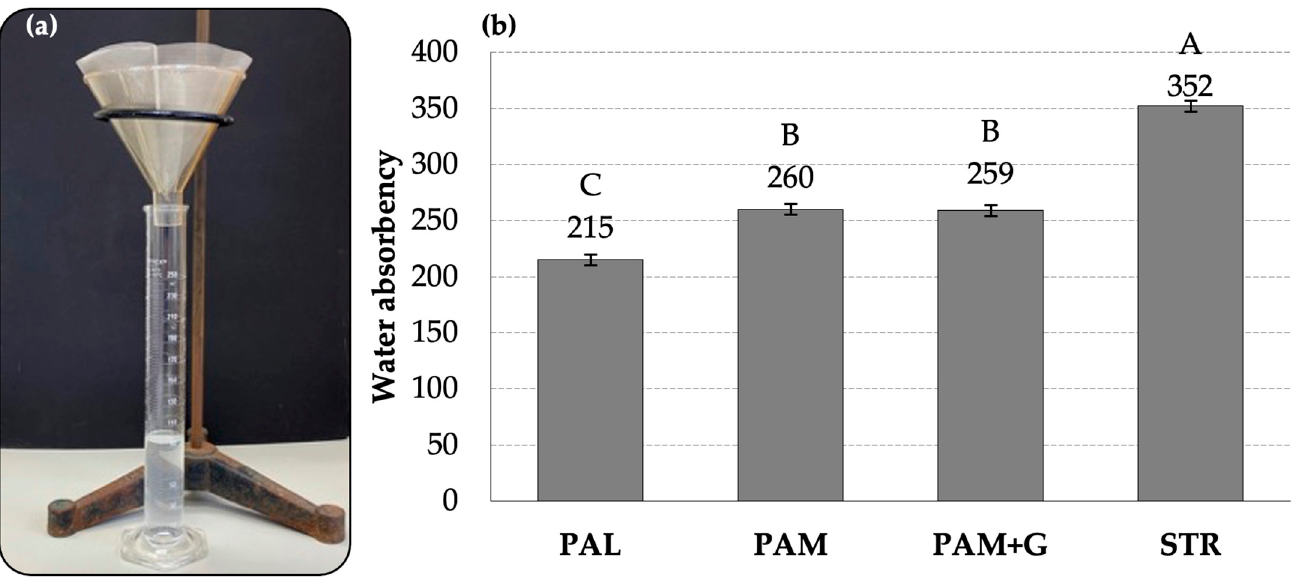
Figure 3. ( a ) The volumetric liquid absorption method used to determine the ( b ) water absorbency (g water per g polymer) of different SAPs. Different letters indicate significant differences among water absorbency of different polymers ( p < 0.05).